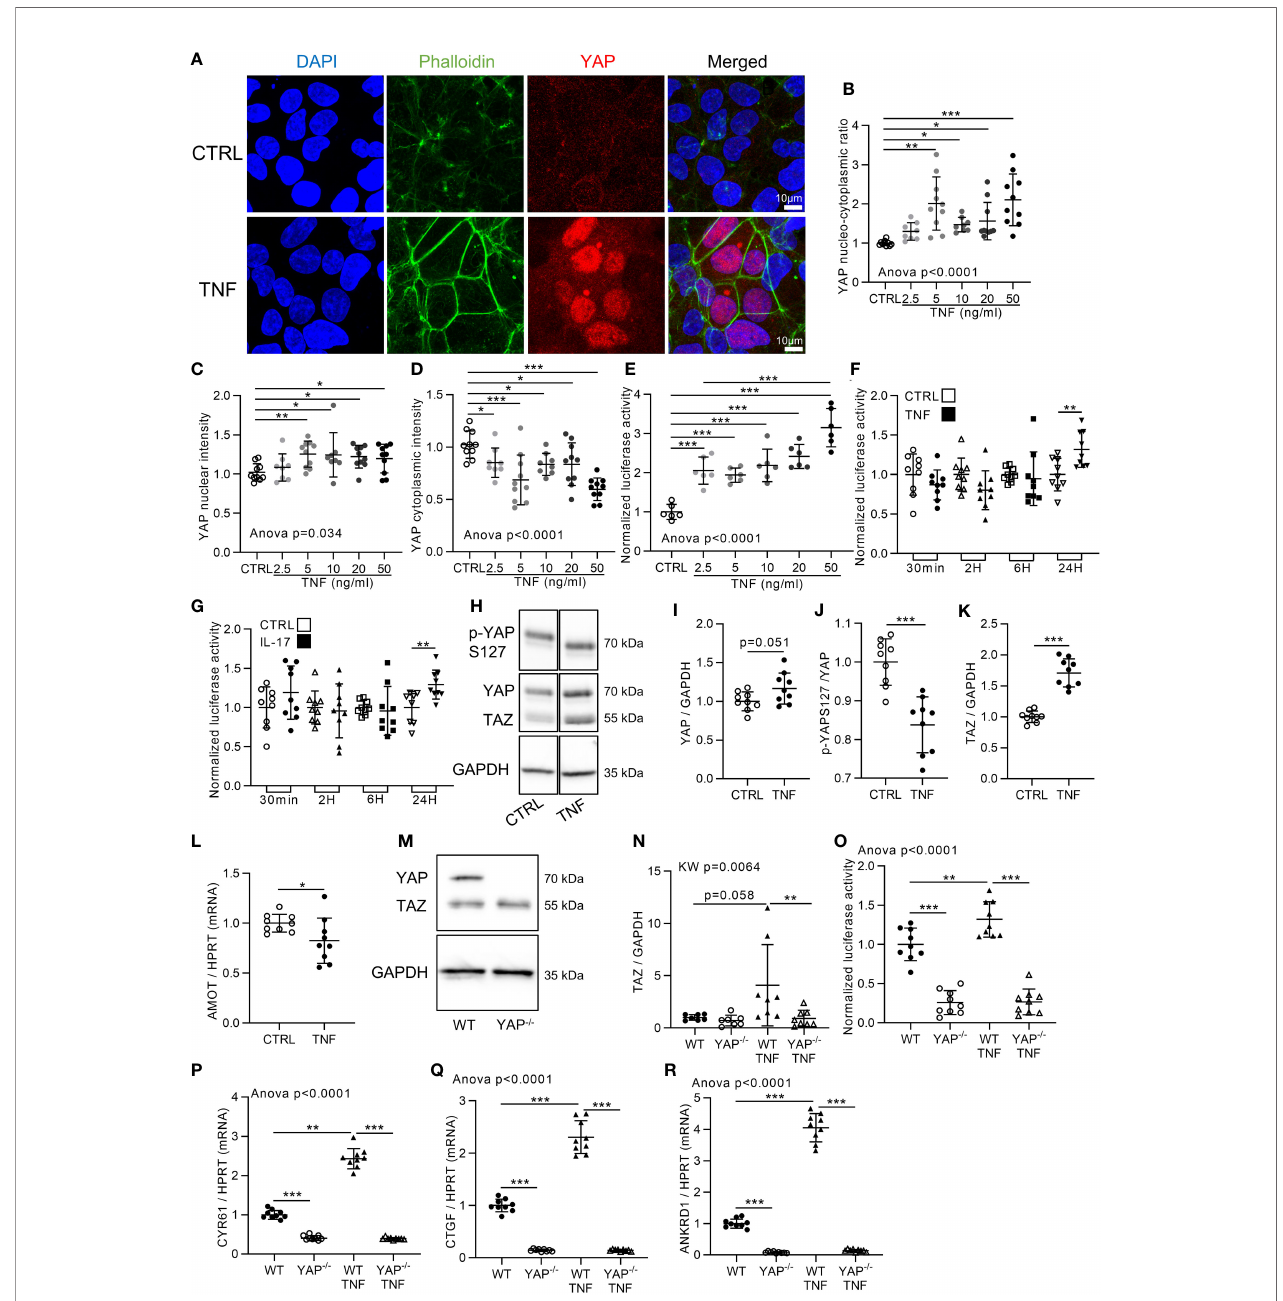
FIGURE 1 | YAP transcriptional activity is increased by TNF and IL-17. HEK293 were seeded at 100,000 cells/cm 2 on fi bronectin coated culture plate. Approximately 24 h after seeding cells were treated with TNF at 10 ng/ml for 48 h [or 24 h for (F) , (G) and (O) ]. (A) Representative airyscan confocal z-stack max intensity images of YAP (immuno fl uorescence (IF) technique, red), phalloidin (actin, green), DAPI (nucleus, blue), and merged images (luminosity and contrast were enhanced identically for each image for clarity purpose). (B – D) Corresponding IF quanti fi cation, with the nucleo-cytoplasmic ratio of YAP labeling (B) , YAP mean nuclear intensity (C) and YAP mean cytoplasmic intensity (D) . (E – G) Luciferase reporter assay of TEAD transcription factor activity upon different TNF concentrations at 24 h of treatment (E) or at different timings with 10 ng/ml of TNF (F) or 50 ng/ml of IL-17 (G) as indicated. (H – K) Representative western blot of YAP phosphorylation on serin 127 (YAPS127), YAP/TAZ and GAPDH for control or TNF treated cells (H) with their respective quanti fi cations as indicated (I – K) . (L) RT-qPCR result for AMOT, results were normalized to HPRT expression. (M, N) Representative western blot of YAP/TAZ and GAPDH for WT and YAP − / − cells (M) with respective TAZ quanti fi cation (N) . (O) Luciferase reporter assay of TEAD transcription factor activity in WT and YAP − / − control or TNF treated cells. (P – R) RT-qPCR results for CYR61 (P) , CTGF (Q) , and ANKRD1 (R) , results were normalized to HPRT expression. Results are representative of three independent experiments with 2 to 4 biological replicates for each experiment (n = 6 to 10 per group) with T-test or one-way ANOVA test and FDR corrected for multiple comparisons post hoc tests performed between conditions: *p < 0.05; **p < 0.01; ***p < 0.001. Data are expressed as fold change vs. control and presented as individual values with mean ±